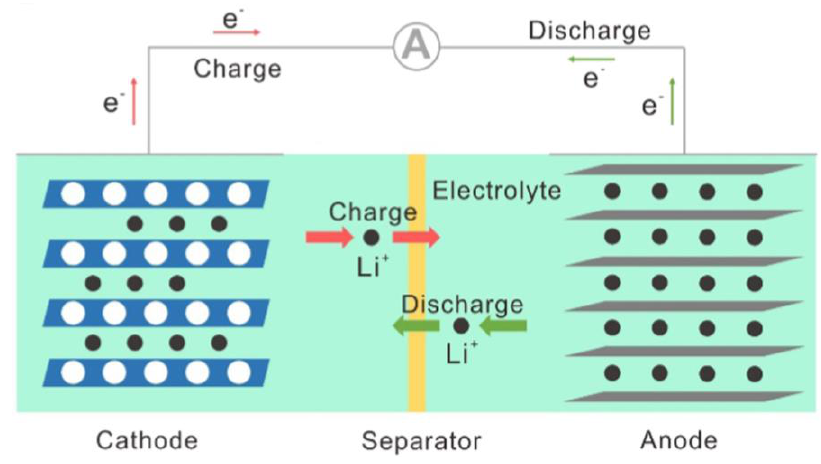
Figure 1. Lithium-ion battery working principle diagram [28]. Table 2. Technical parameters of Li-ion batteries.